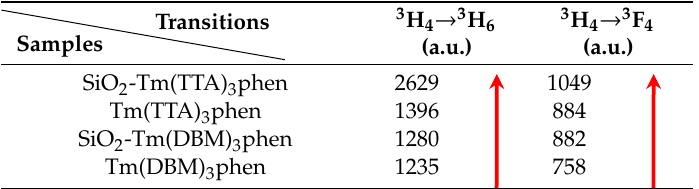
Table 1. Enhancement of fluorescence intensity of Tm 3 + complexes and SiO 2 -Tm 3 + hybrid materials.